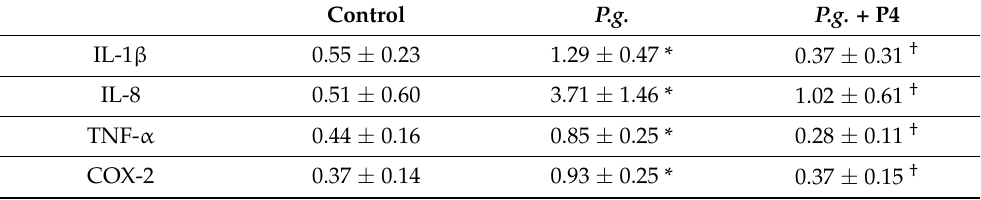
Table 2. Gene expression of cytokines and COX-2 in the fetal membrane. The transcript levels of inflammatory cytokines (IL1b, IL-8, and TNF- α ) and COX2 in the fetal membrane were determined by real-time RT-PCR in each group (control, P.g. , and P.g. + P4). Experiments were performed in duplicate using eight independent tissue samples. Statistical analysis was performed using the Mann–Whitney U test. Statistical significance was set at *: p < 0.05, †: p < 0.05 compared P.g. with the control or P.g. + P4 with P.g. , respectively. Values represent the mean ± SD (n = 8). Control P.g. P.g. + P4 IL-1 β 0.55 ± 0.23